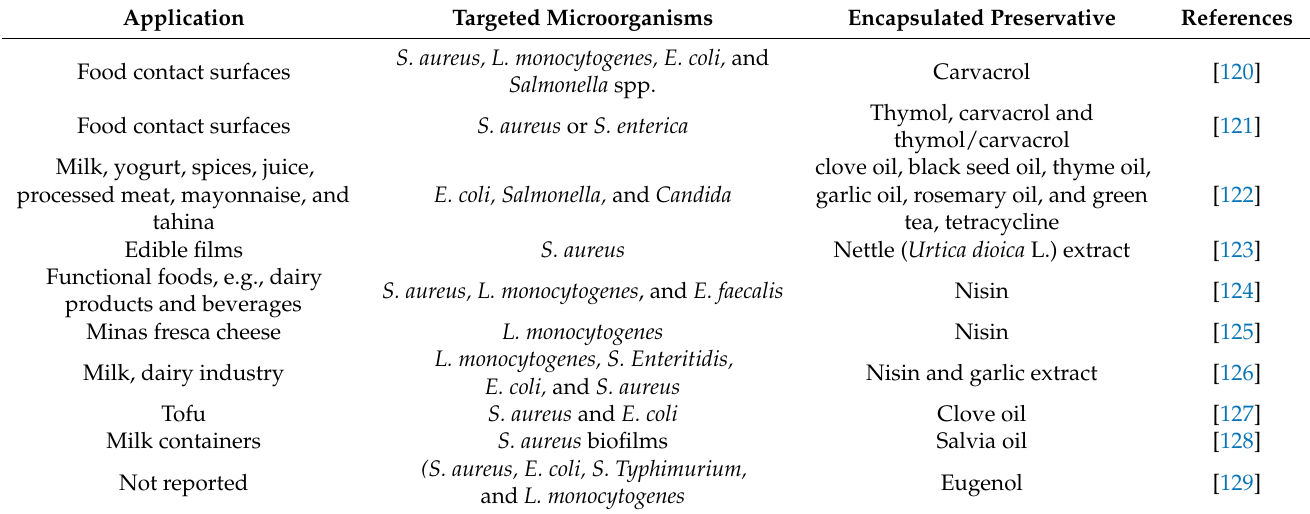
Table 4. Applications of nanoliposomes in the food